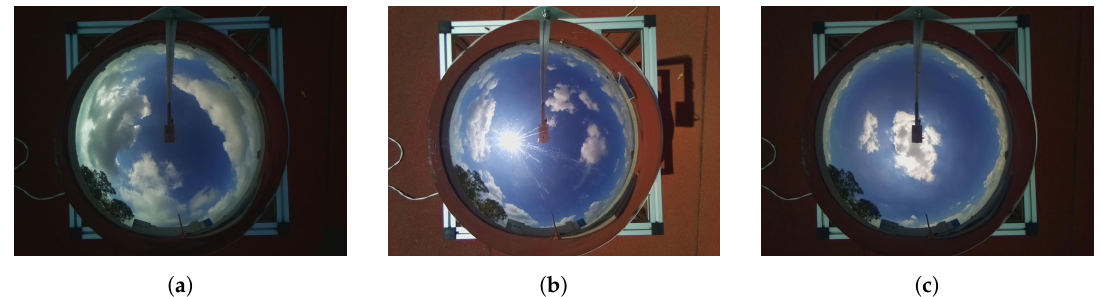
Figure 18. Representative examples of cloudy day conditions. ( a ) shows an image taken at 10:00, while ( b , c ) show an image taken at 12:15 and 14:00, respectively.